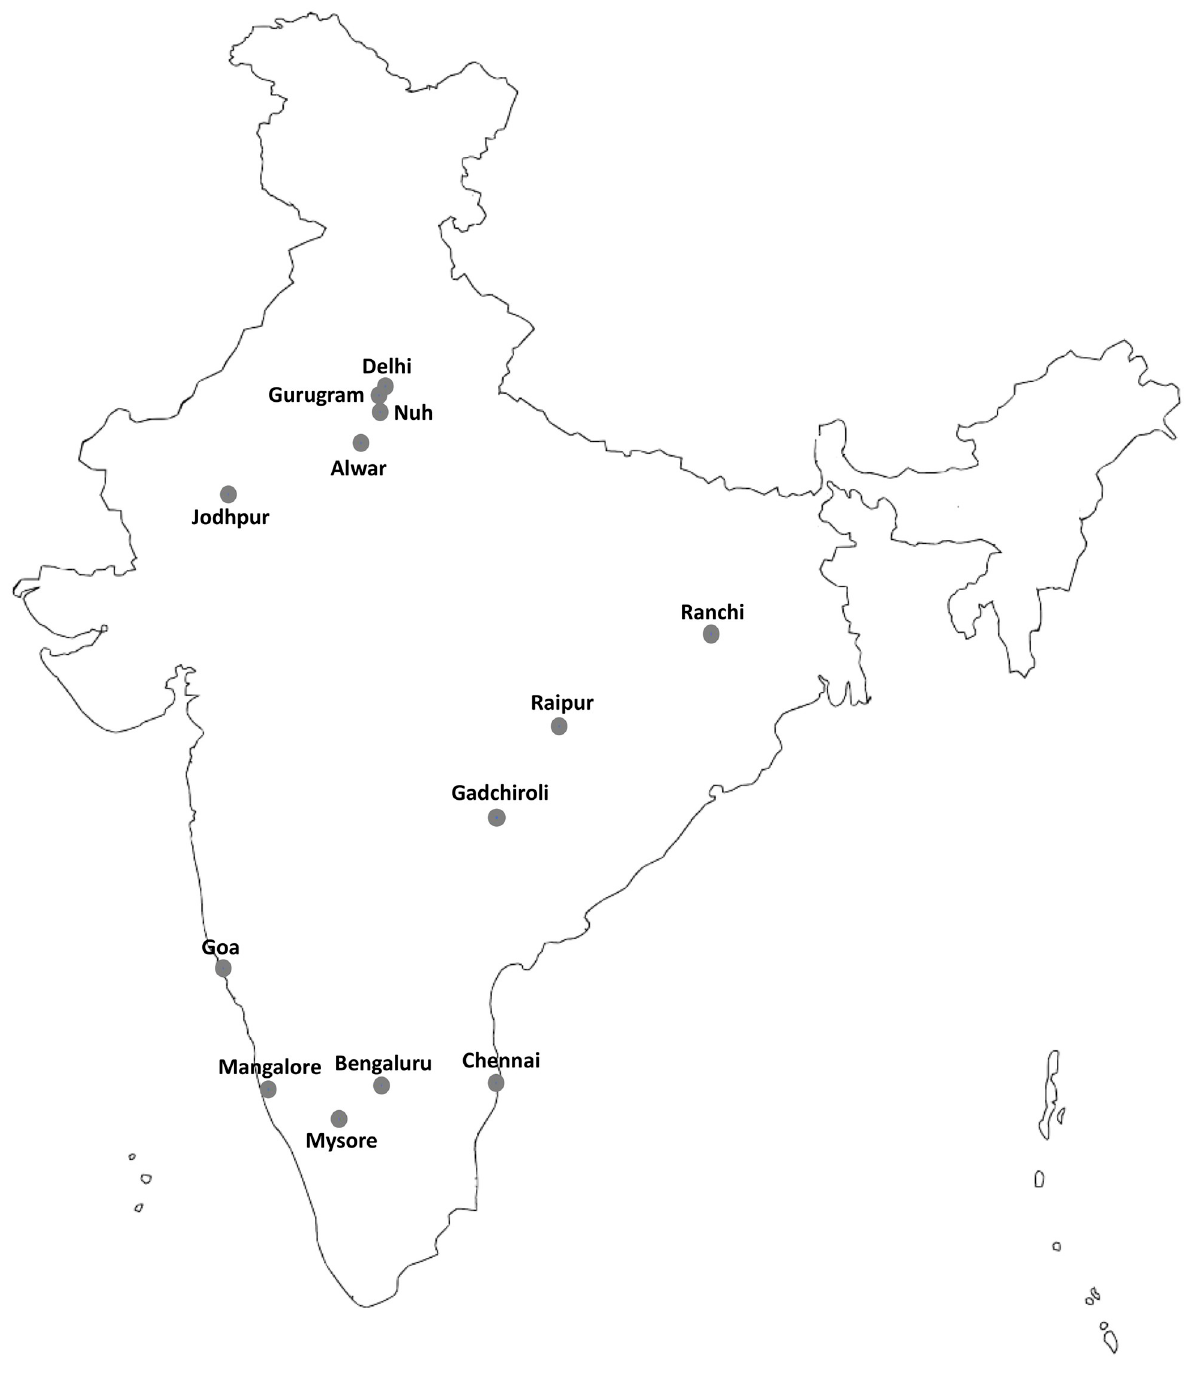
Fig 1. Geographical location of mosquito sampling